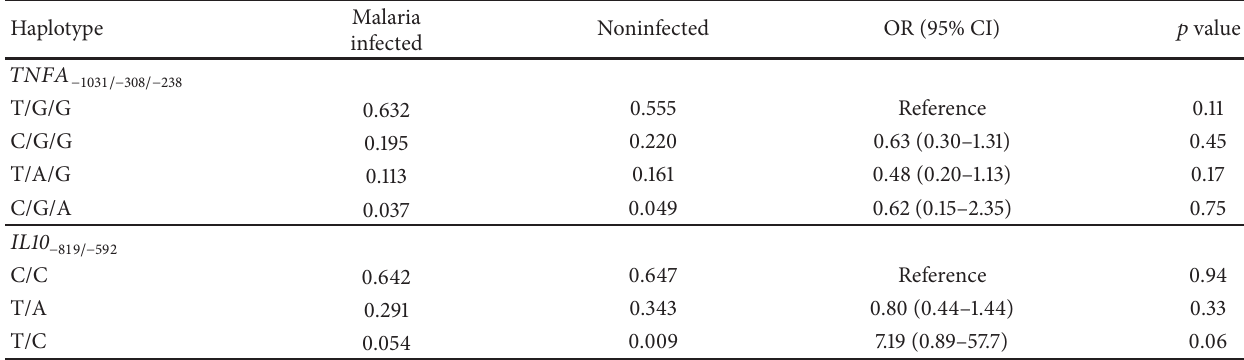
Table 3: Haplotype frequencies in the TNF and IL10 genes in vivax malaria-infected and noninfected individuals. Malaria Haplotype infected